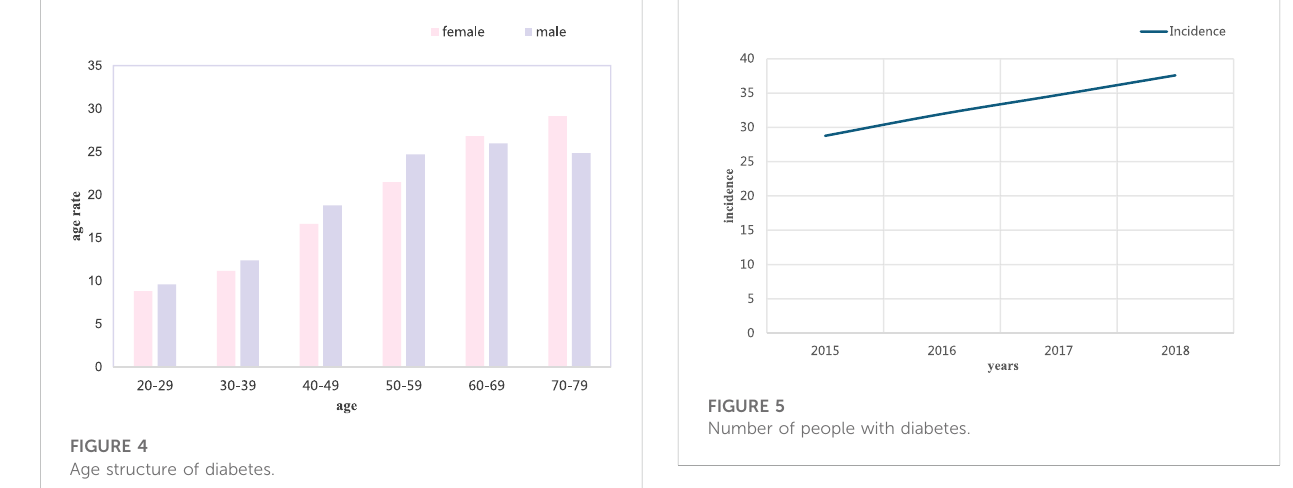
FIGURE 5 Number of people with